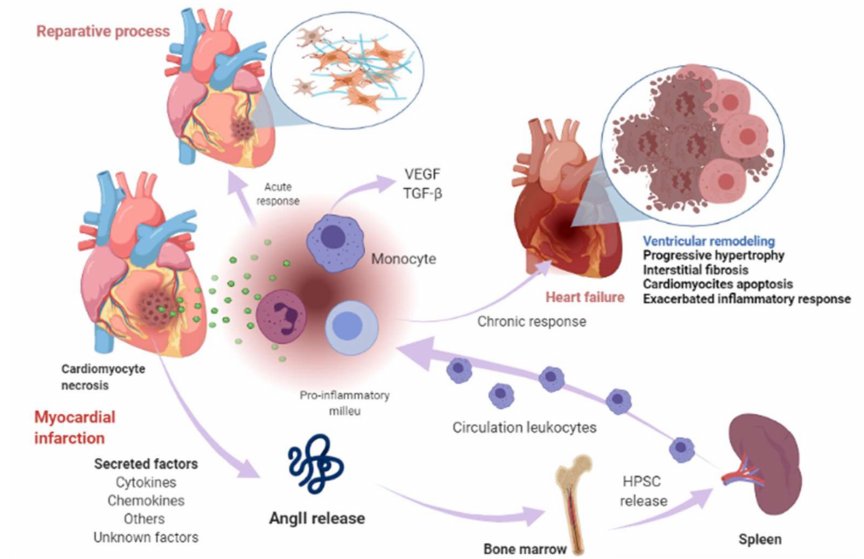
Figure 1. Myocardial infarction and heart-failure-related events. Shortly after myocardial injury, an increase in AngII concentration occurs and induces an accumulation, differentiation, and exit of hematopoietic stem/precursor cells (HPSC) from the bone marrow to contribute to splenic myelopoiesis to supply the infarcted area of the immune cells. Cardiomyocyte necrosis releases signals of danger and induces the secretion of cytokines, chemokines, and adhesion molecules to allow the recruitment and infiltration of leukocytes (mainly monocytes) into the infarcted area. Monocytes exert a reparative response, phagocytosing the cellular debris, while it stimulates repair pathways by secreting pro-inflammatory cytokines through the binding of angiotensin-II (AngII) to type 1 angiotensin-II receptor (AT1R), which induces the phosphorylation of nuclear factor-kappa B (NF-kB). This induces a pro-inflammatory response mediated by tumor necrosis factor-alpha (TNF- α ) or interleukin-1 beta (IL1ß) and drives inflammation. The modulation of inflammation in this repair phase includes fibroblast activation and healing mediated in part by renin-angiotensin- aldosterone system (RAAS). When this response becomes chronic, it leads to a pathological process called ventricular remodeling, characterized by progressive hypertrophy of myocytes and interstitial fibrosis, which in later stages involve progressive loss of myocytes through apoptosis, an exacerbated inflammatory response. The healing and the adverse remodeling of the infarcted ventricle ultimately underlie heart failure. This environment can lead to the secretion of certain factors into the circulation that are synthesized in various cell types in the heart, including cardiomyocytes, fibroblasts, smooth muscle, and vascular endothelial cells and other unknown factors. Image created with BioRender.com (Toronto, ON,